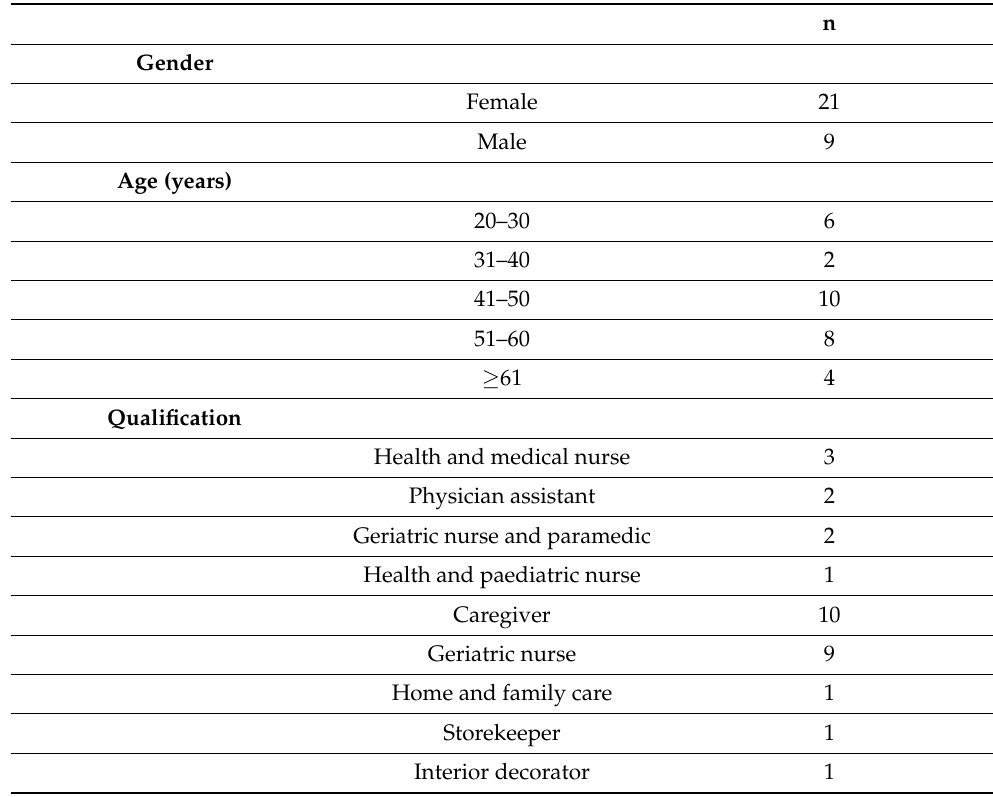
Table 2. Participant